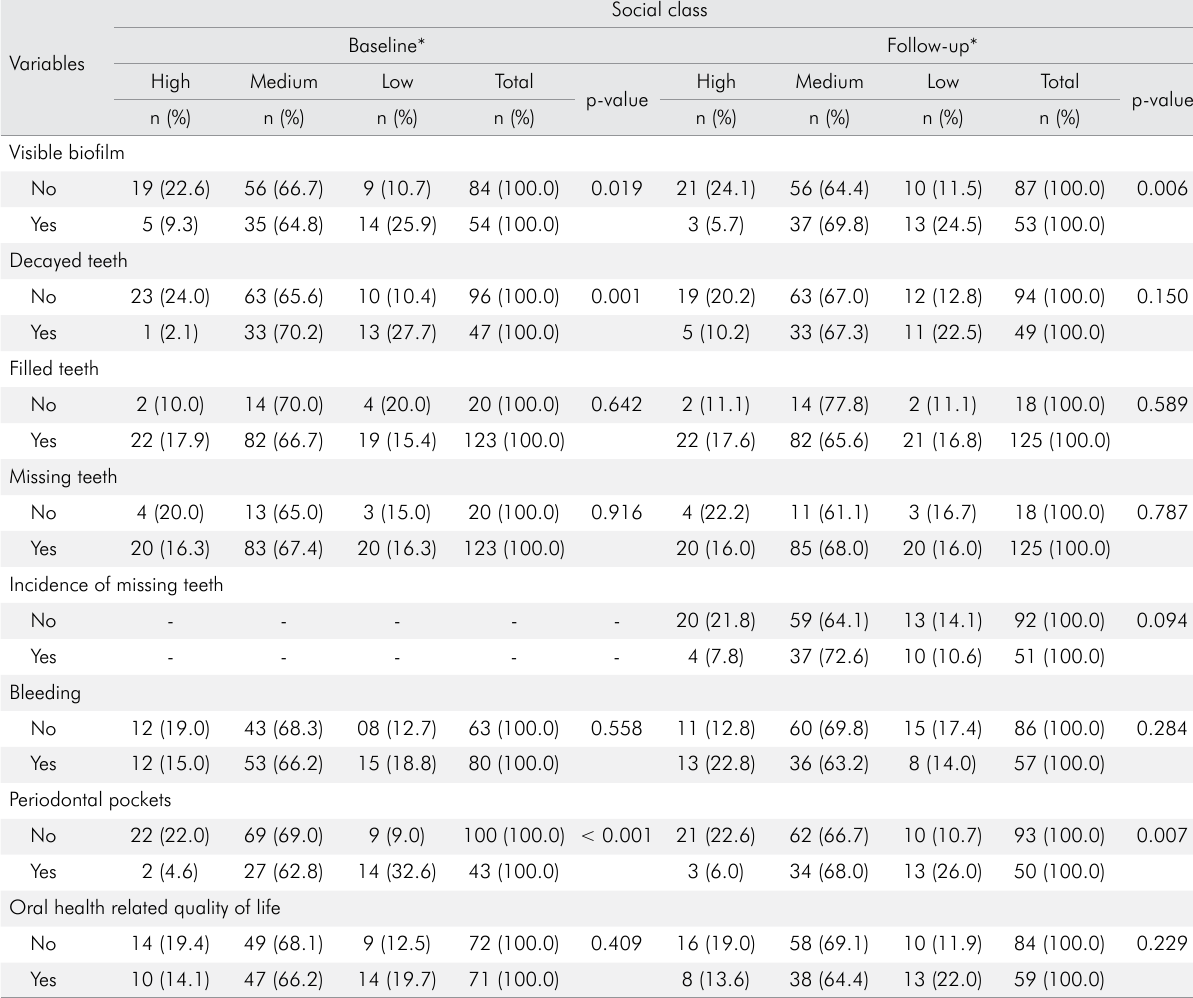
Table 2. Association between social class and adult oral health variables. Piracicaba, SP, Brazil, 2011-2015.